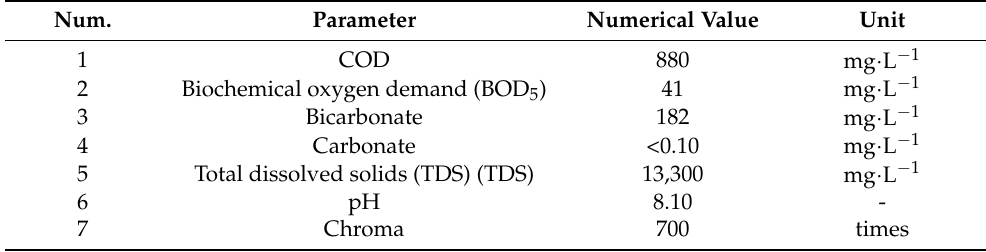
Table 1. Composition of wastewater. Num.